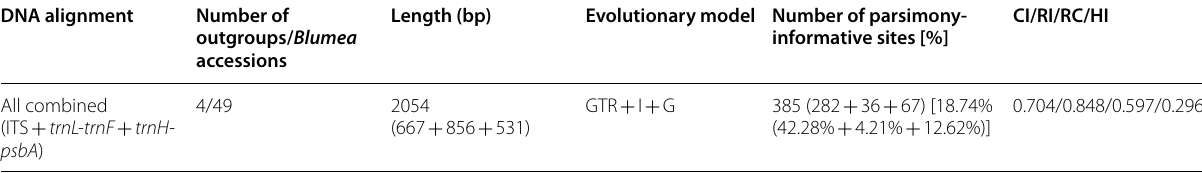
CI consistency index; RI retention index; RC rescaled consistency index; HI homoplasy index